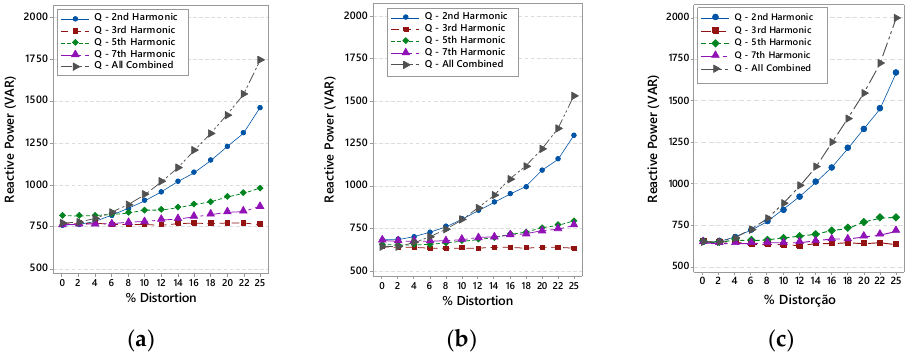
Figure 9. Reactive power increase for 2nd, 3rd, 5th, 7th and all harmonic order combined for induction motors ( a ) IE2 SCIM; ( b ) IE3 SCIM; ( c ) IE4 LSPMM.